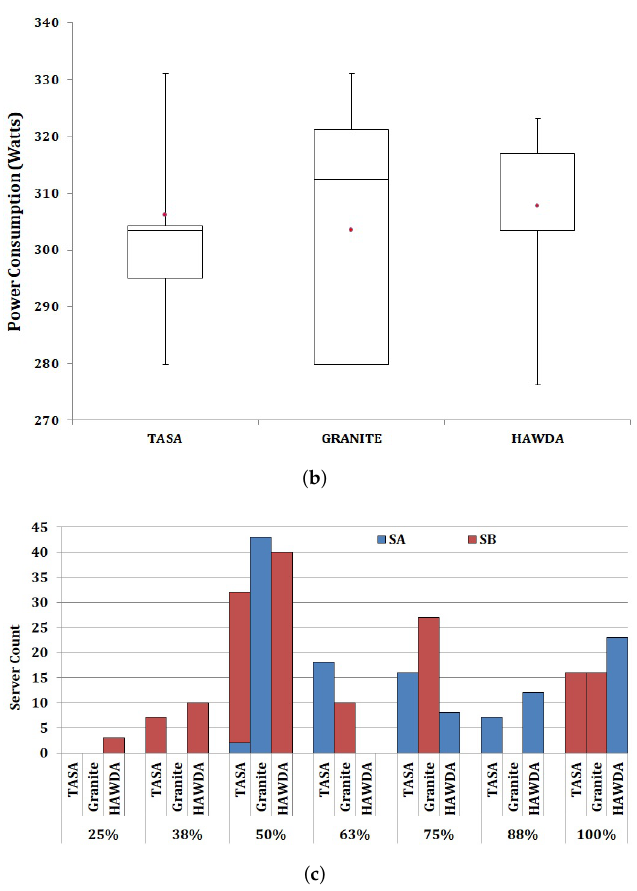
Figure 3. Outlet temperature, power consumption, and percentage utilization of servers on deploy- ment of all VM batches after server relocation: ( a ) outlet temperature after server relocation, ( b ) power consumption after server relocation, and ( c ) percentage utilization of servers after server